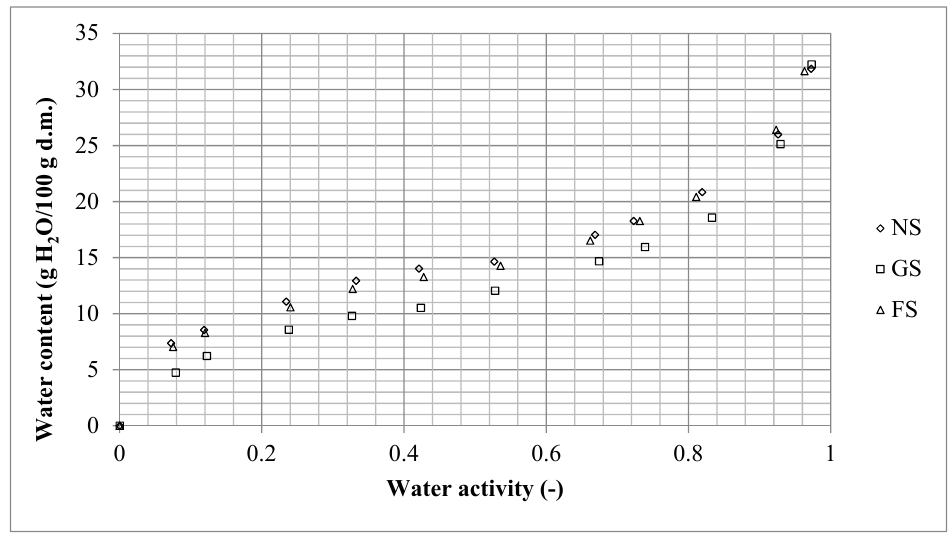
Figure 1. Comparison of water vapor sorption isotherms of native starch (NS), starch granulate (SG), and fermented starch (FS) at a temp. of 20 ◦ C. Source: results of the present